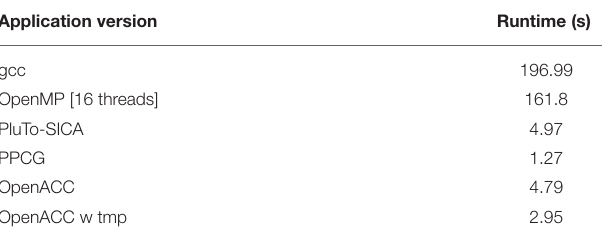
TABLE 2 | Runtimes of matrix multiplication of two 4096 square matrices.